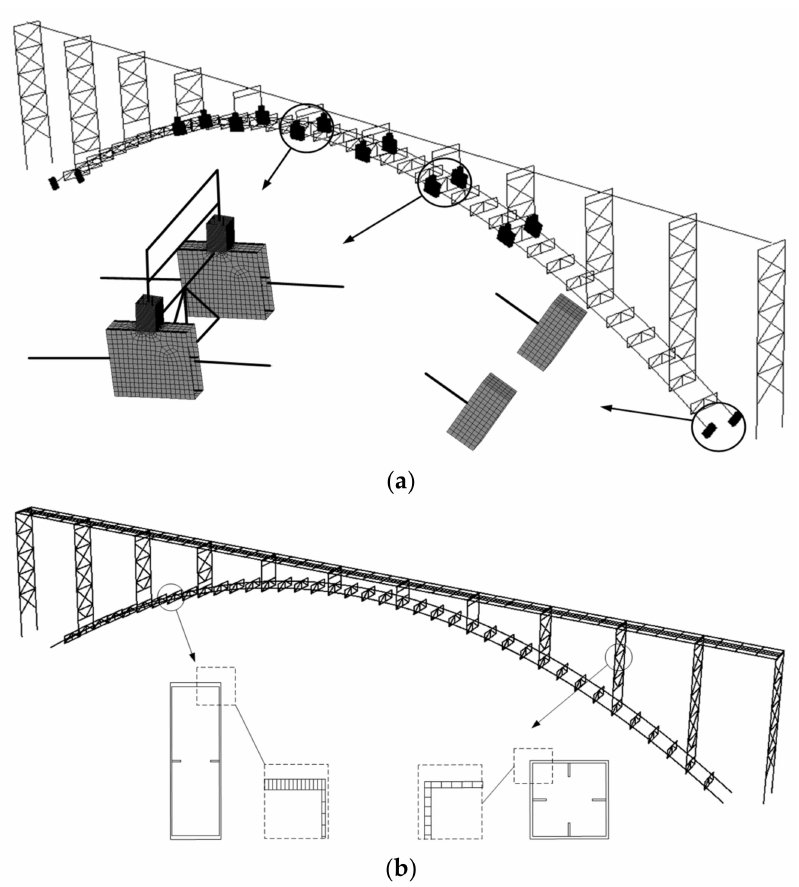
Figure 9. FE models: ( a ) hybrid element model; ( b ) beam element model.